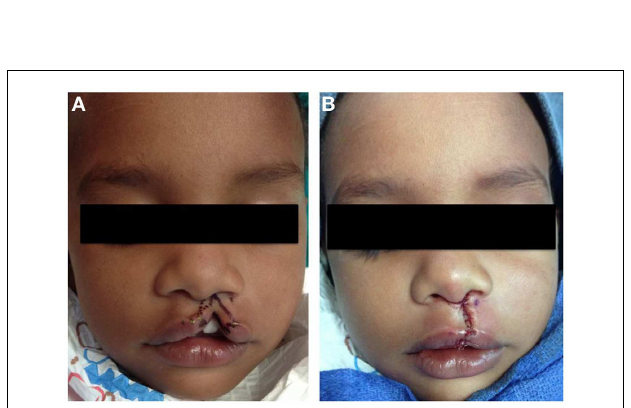
FIGURE 3 | Repair of left incomplete lip using triangular flap technique . (A) Preoperative photo, (B) preoperative photo with marking, (C) status post